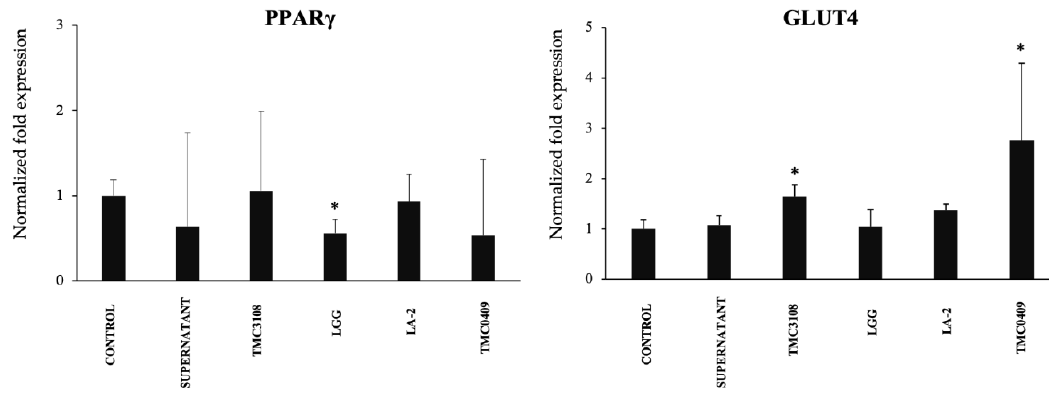
Figure 12. Immunobiotic mediated regulation of adipocyte di ff erentiation in an immune cell-adipocyte co-culture model. The mRNA expressions of PPAR γ and GLUT4 resulted from various immunobiotic lactic acid bacteria (LAB) stimulation into the co-culture model. A total of 1 × 10 6 immune cells / well of 6-well plate were cultured on adipocytes 4-days di ff erentiated. LAB samples (5 × 10 8 cells / well) also added into the adipocyte plate and maintained for further 2 or 4 Days. All data shown are the average ± SD of 3 independent experiments performed in triplicate. The asterisk (*) indicated statistical di ff erences when compared with control at the significance level of p < 0.05. TMC3108, Bifidobacterium bifidum TMC3108; LGG, Lactobacillus rhamnosus GG; LA-2, Lactobacillus rhamnosus LA-2; TMC0409, Lactobacillus paracasei